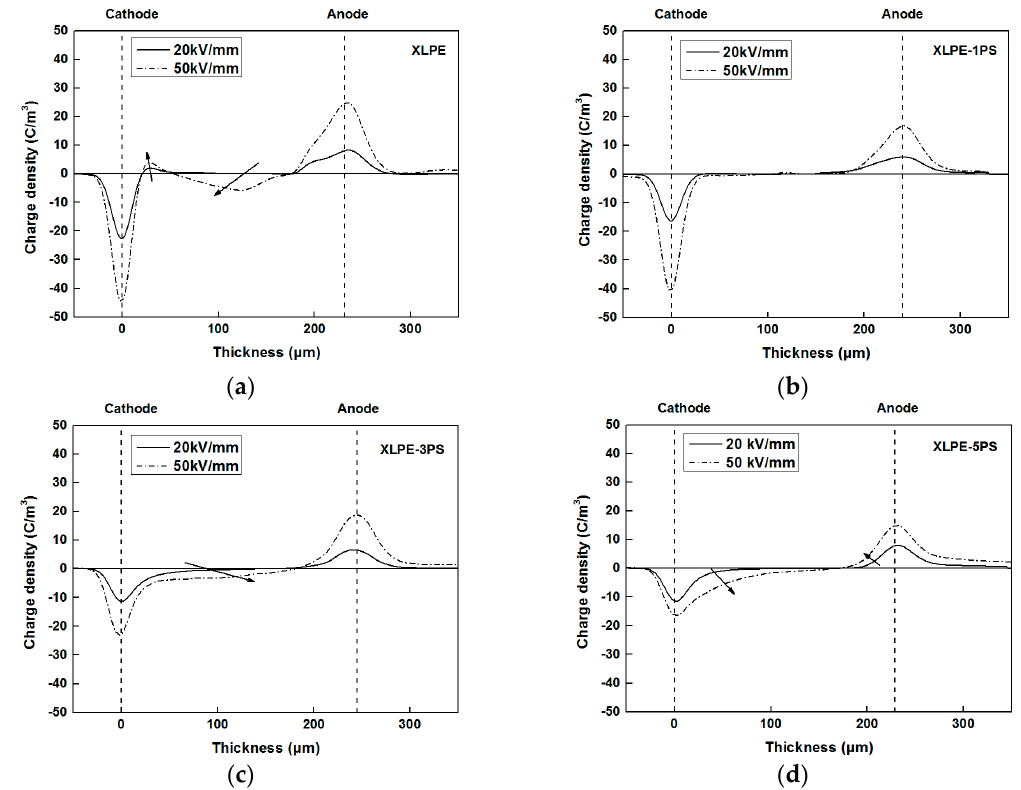
Figure 2. Space charge distribution of samples of ( a ) crosslinked polyethylene (XLPE); ( b ) XLPE-1PS; ( c ) XLPE-3PS; ( d ) XLPE-5PS.